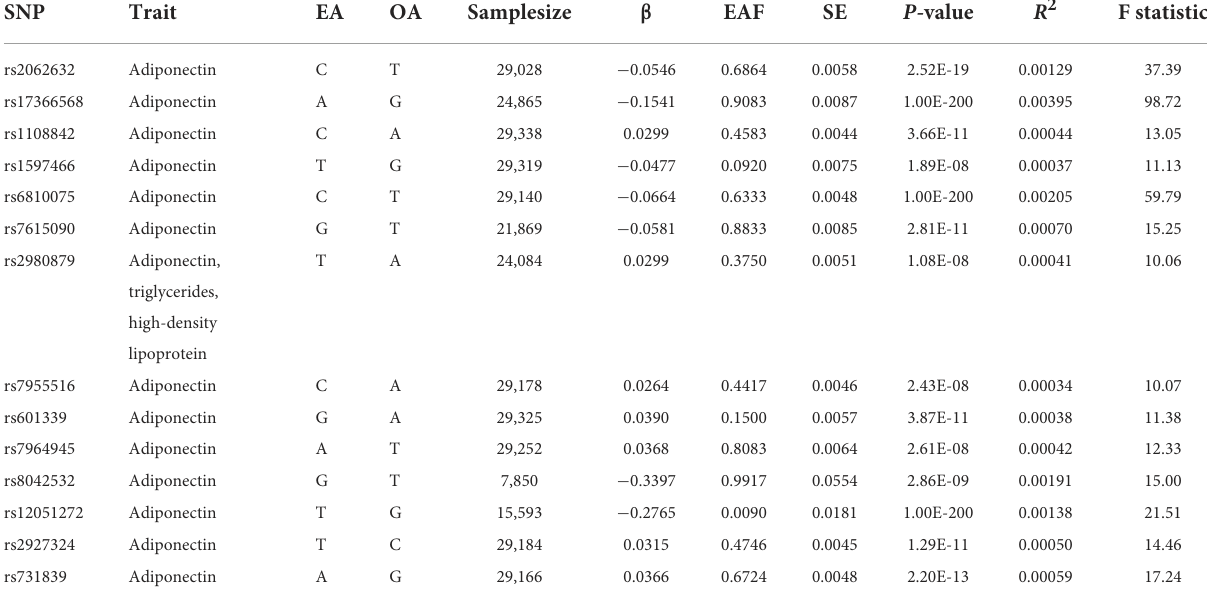
TABLE 2 Characteristics of instrumental variables for circulating adiponectin.